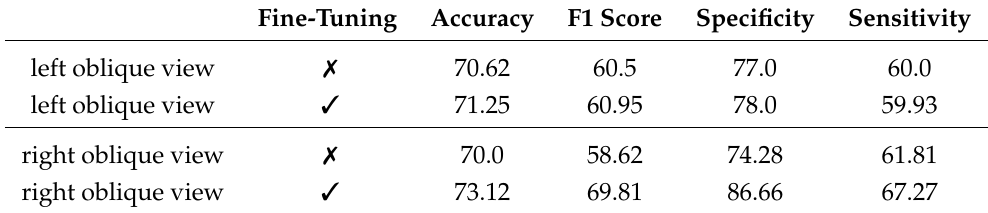
Table 4. Result of fine-tuning in left and right oblique view,